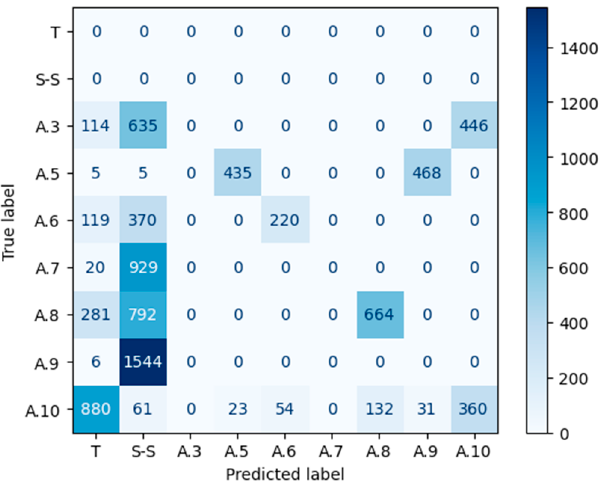
Figure 16. Levels 1 and 2 confusion matrix. Table 6. Classification report of the level 1 and 2 anomalies.